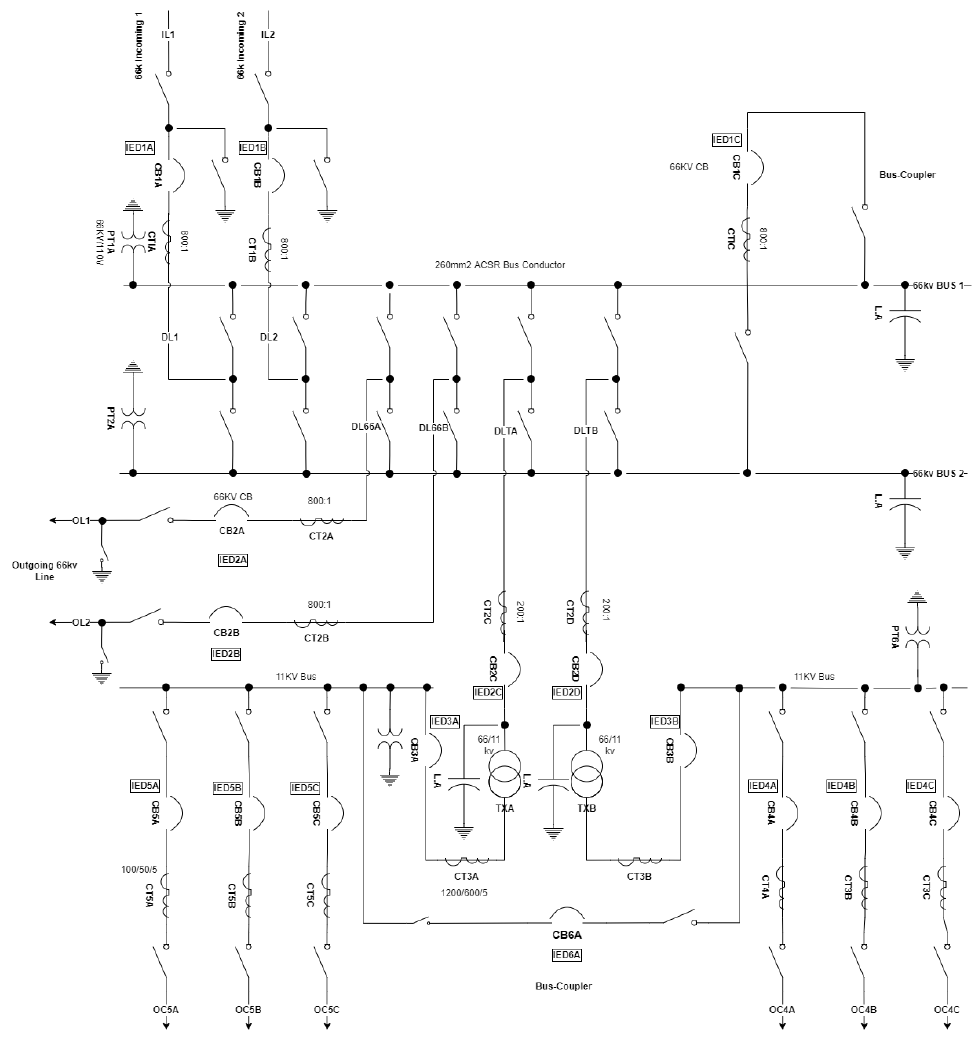
Figure 6. Labelled single-line diagram of 66/11 kV substation (adapted from